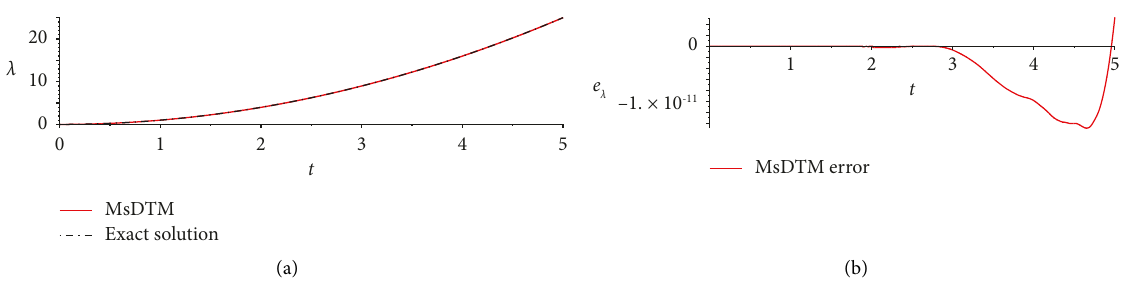
Figure 11: The approximate solution component λ (a) and the absolute error e